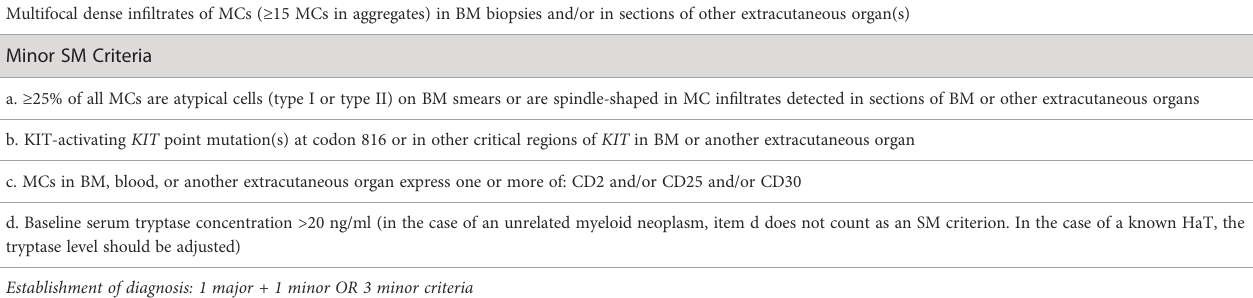
TABLE 1 SM Diagnostic Criteria (2021